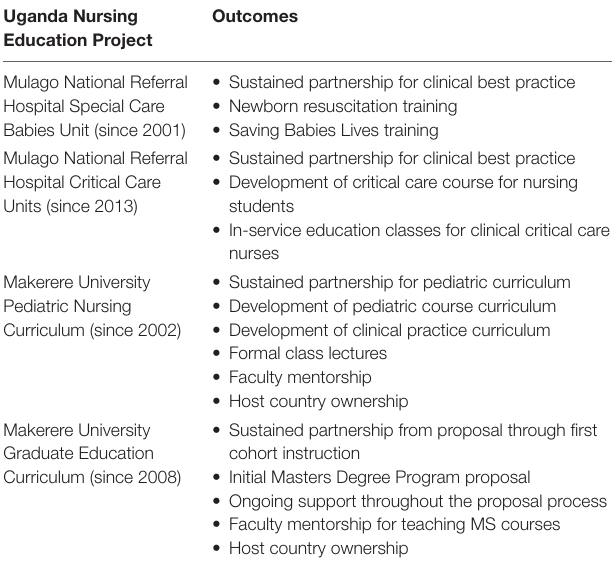
taBle 2 | Case exemplar